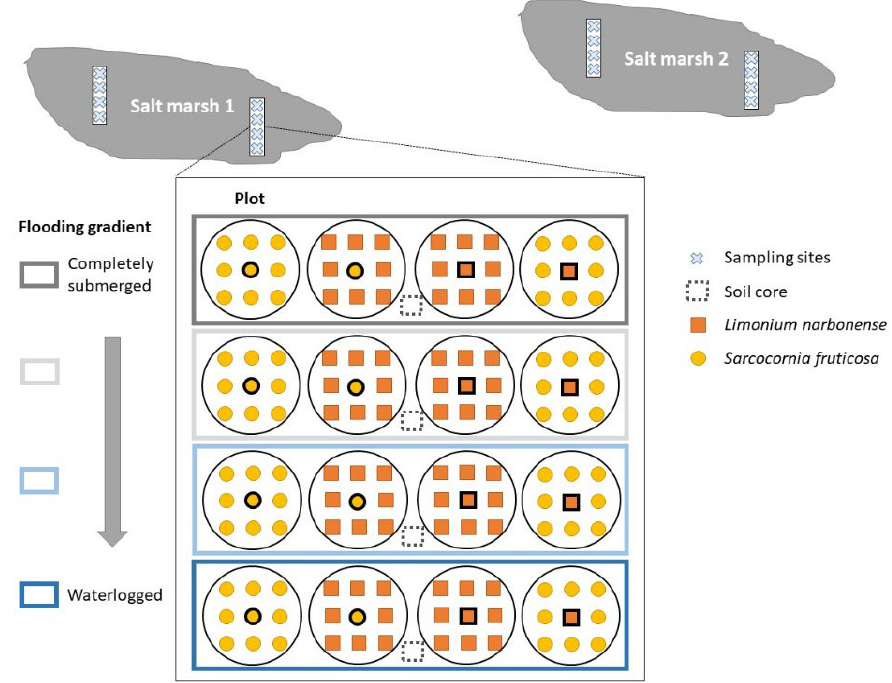
Figure 6. Schematic view of the sampling design. Four transects were selected in two salt marshes following the flooding gradient. Intra- and interspecific competition of the salt marsh species Limonium narbonense and Sarcocornia fruticosa were assessed in circular plots of 20 cm diameter. The central individual in each plot was sampled for further analyses. In each sampling site, the flooding intensity was monitored for 14 days and a core of surficial soil was